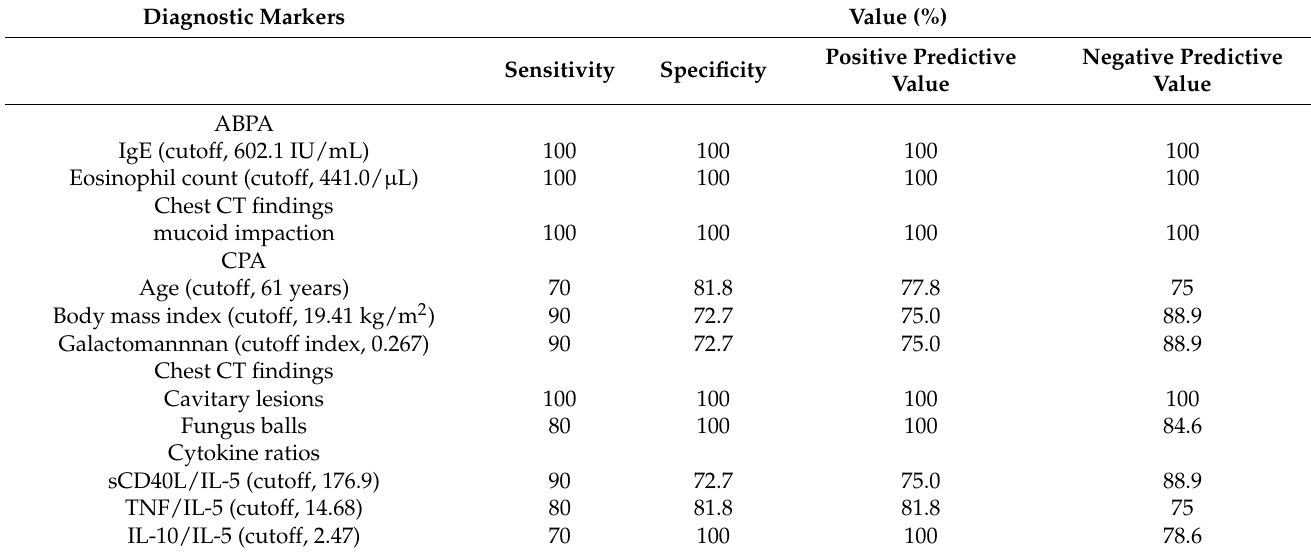
Table 3. Diagnostic performance of markers for ABPA and